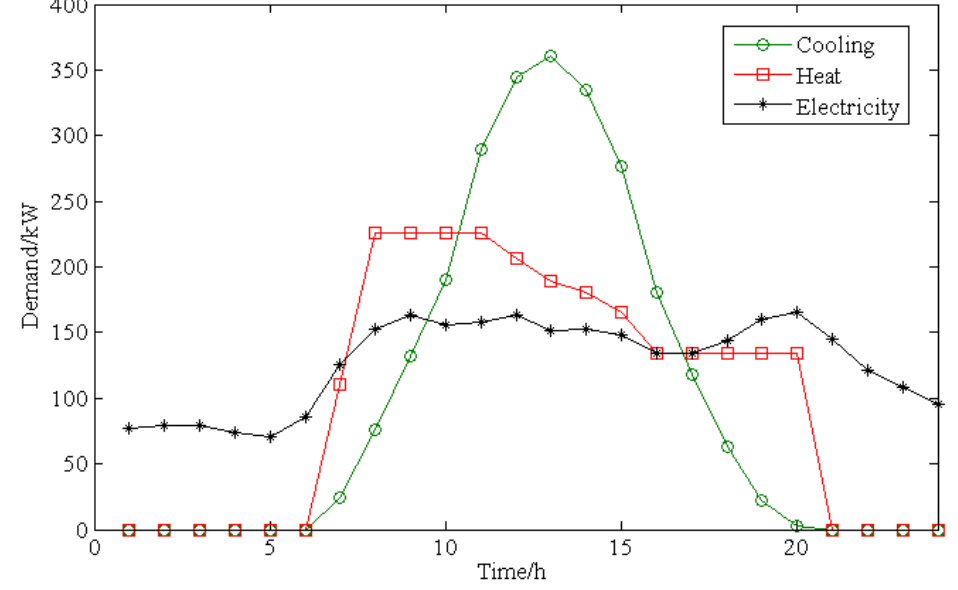
Figure 12. The hourly energy demands for regional end users.